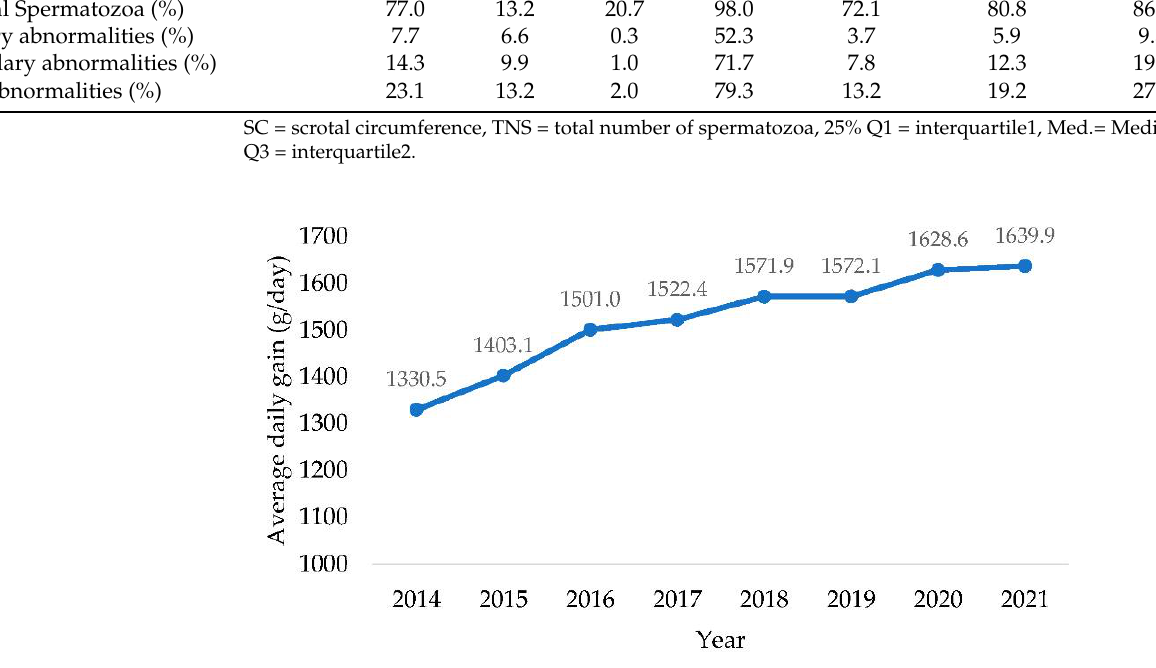
Table 2. Descriptive statistics about physiological and seminal characteristics of Italian Simmental young bulls.